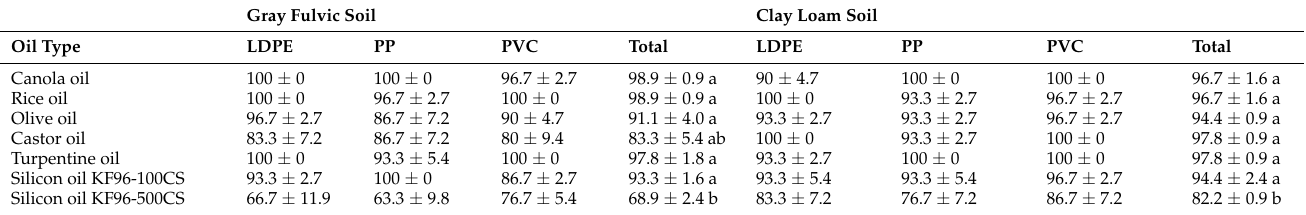
Table 3. Selection of the suitable oil type for plastic separation from soil (LDPE + PP + PVC particle mix, the initial number of pieces was 30 in